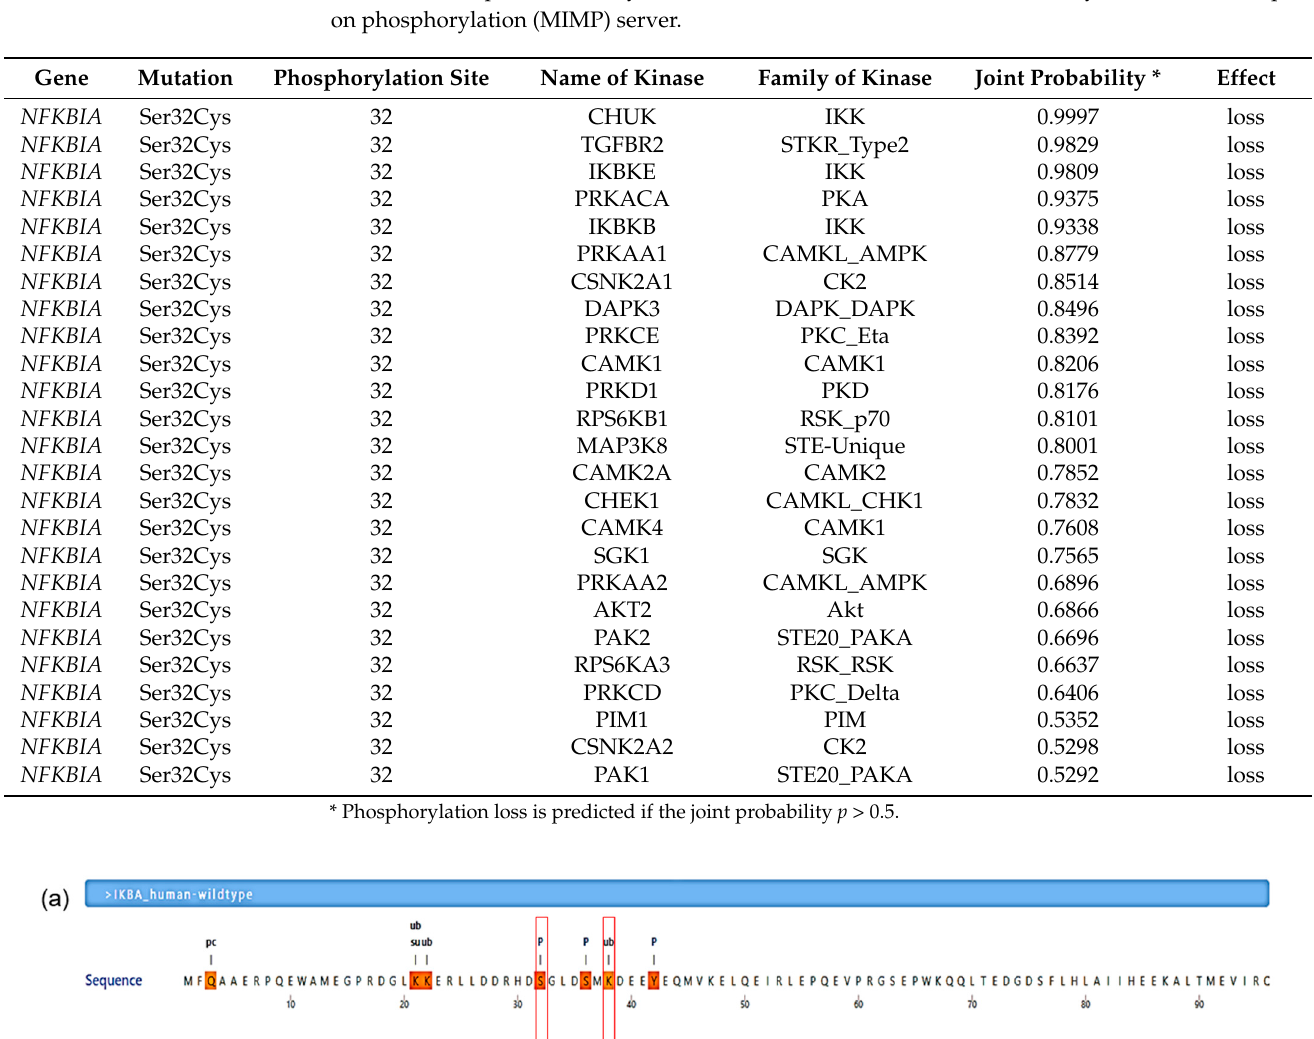
Table 2. The impact of Ser32Cys mutation on kinase–substrate interactions by the mutations impact on phosphorylation (MIMP) server.